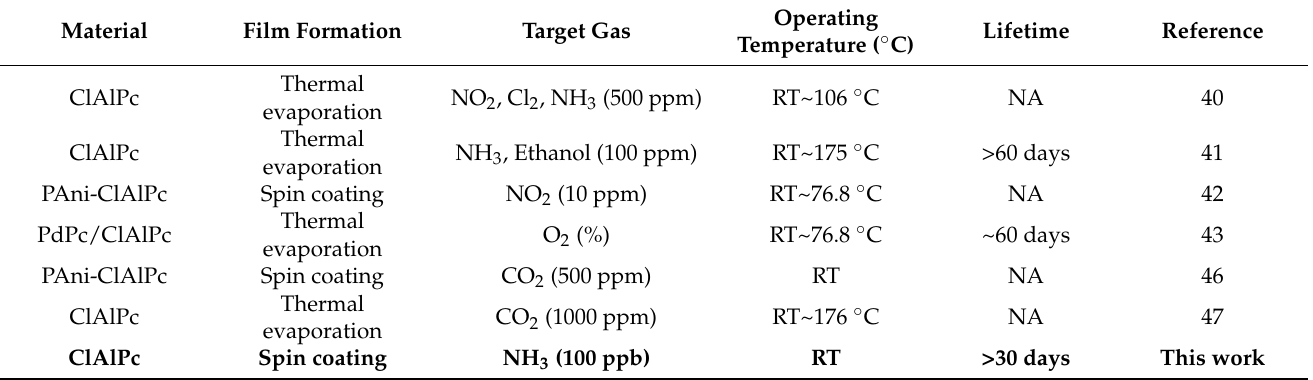
Figure 4. ( a ) The device current at an operating voltage of 5 V, and ( b ) NH 3 sensing response of ClAlPc sensor on different days. The ClAlPc sensor was stored at ambient conditions. Table 1. Comparison of reported gas sensors based on chloroaluminum